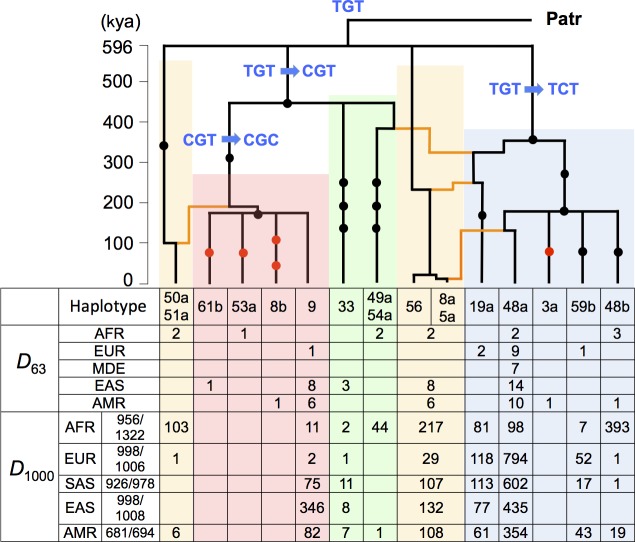
Ancestral recombination graph in the human ST8SIA2 promoter region.Ancestral recombination events in the 10-kb core LD region are inferred by comparing tree topologies between two neighboring blocks 1 and 2 (S6 Fig and S7 Table). The gene trees for blocks 1 and 2 are drawn simultaneously with required recombination events (orange lines). Dots on branches represent SNPs in block 2, of which five SNPs shown by red dots are present in D63 but absent in D1000. The number of each haplotype of block 2 is summarized with their geographic distribution in D63 and D1000.